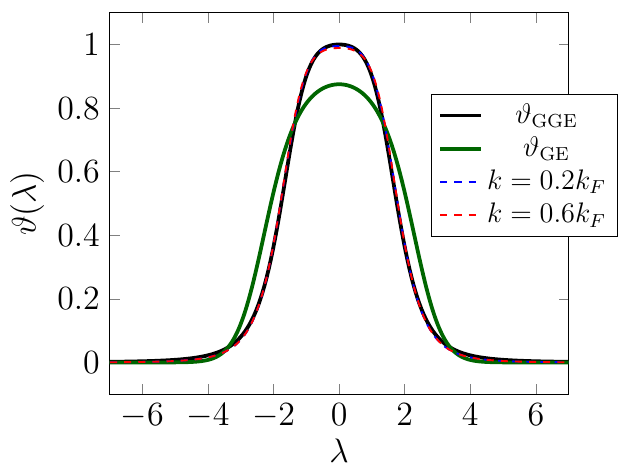
( λ ) (dashed lines) inferred via Eq. (33) Figure 3: Comparison between the distributions ϑ num on the basis of the knowledge of the dynamic structure factor S ( k , ω ) (with k = 0.2 k and F ( λ ) for an interaction quench in the 0.6 k , see the left panel in Fig. 6) and the exact ϑ F GGE Lieb-Liniger model, given in Eqs. (40) and (41) at c = 2 and n = 1 (black solid line). The data at k = 0.2 k are indistinguishable from the exact analytical distribution on this scale. The F ( λ ) with the average energy density and particle density appropriate thermal distribution ϑ GE for the quench under consideration is also reported for comparison (green solid